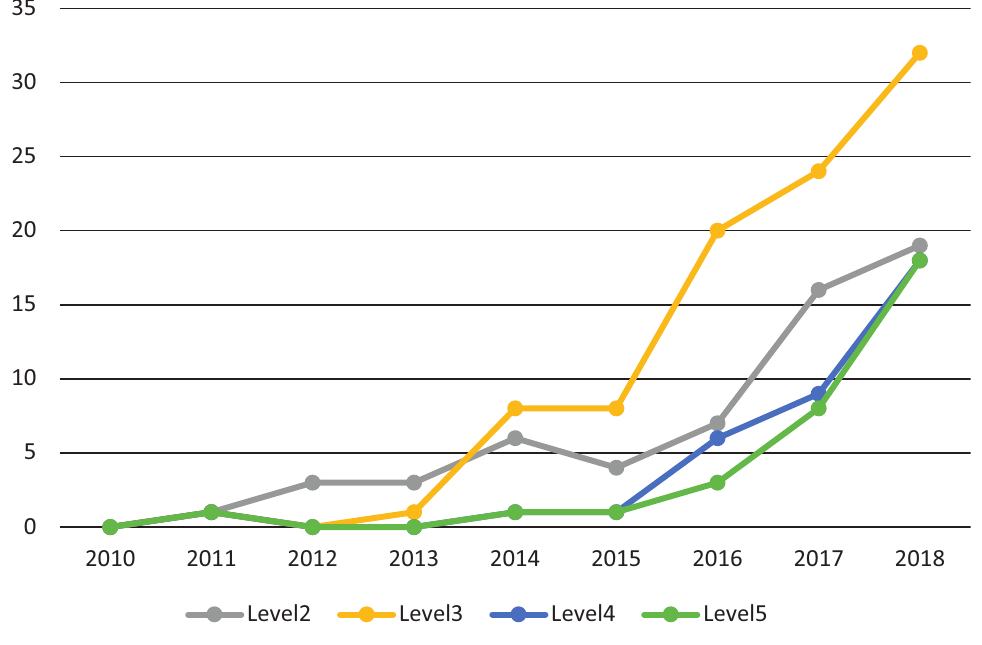
Figure 3. Frequencies ( n ) of ADS papers regarding the investigated SAE level of automation as evolved over time since 2010. SAE L0 and L1 are excluded as they are not part of this literature